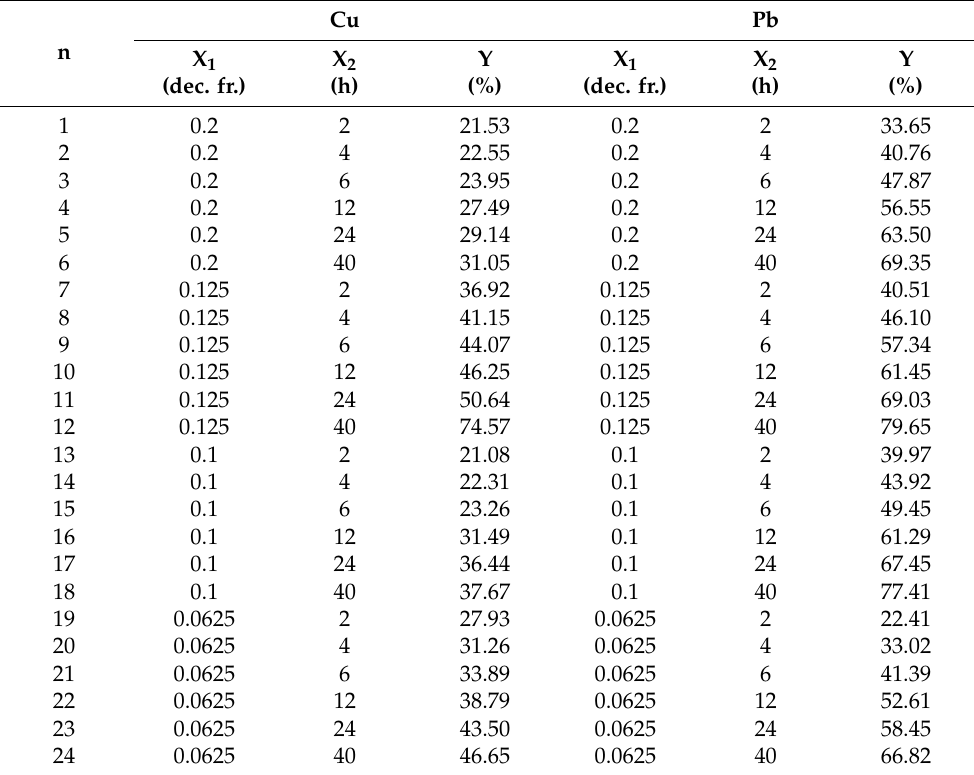
Table 1. Experimental data obtained during soil washing experiments using 2% chitosan solution and used in the elaboration of the mathematical